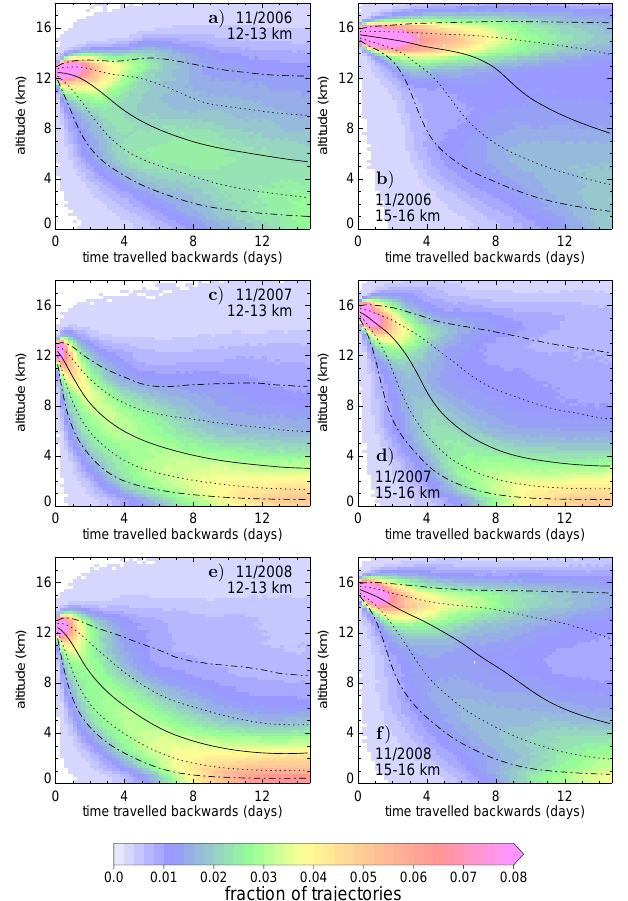
Fig. 6. Probability distributions of trajectory altitude as a function of time travelled backwards during November 2006 (a, b) , 2007 (c, d) and 2008 (e, f) . Plots (a) , (c) and (e) show trajectories started be- tween 12–13km, and plots (b) , (d) and (f) show trajectories started between 15–16km. See additional information in Fig. 2. Fig. 8. Selected halocarbons measured by whole air sampler aboard the WB-57 during CR-AVE (a–c) and TC4 (d–f). Plots a and d show CH 2 Br 2 , b and e show CHBr 3 , and c and f show CH 3 I ; so lifetimesdecrease from left to right. The number of measurements in successive 1 km altitude bins is noted to the right of each plot. The solid black lines show the mean ± 1 standard deviation in each bin.